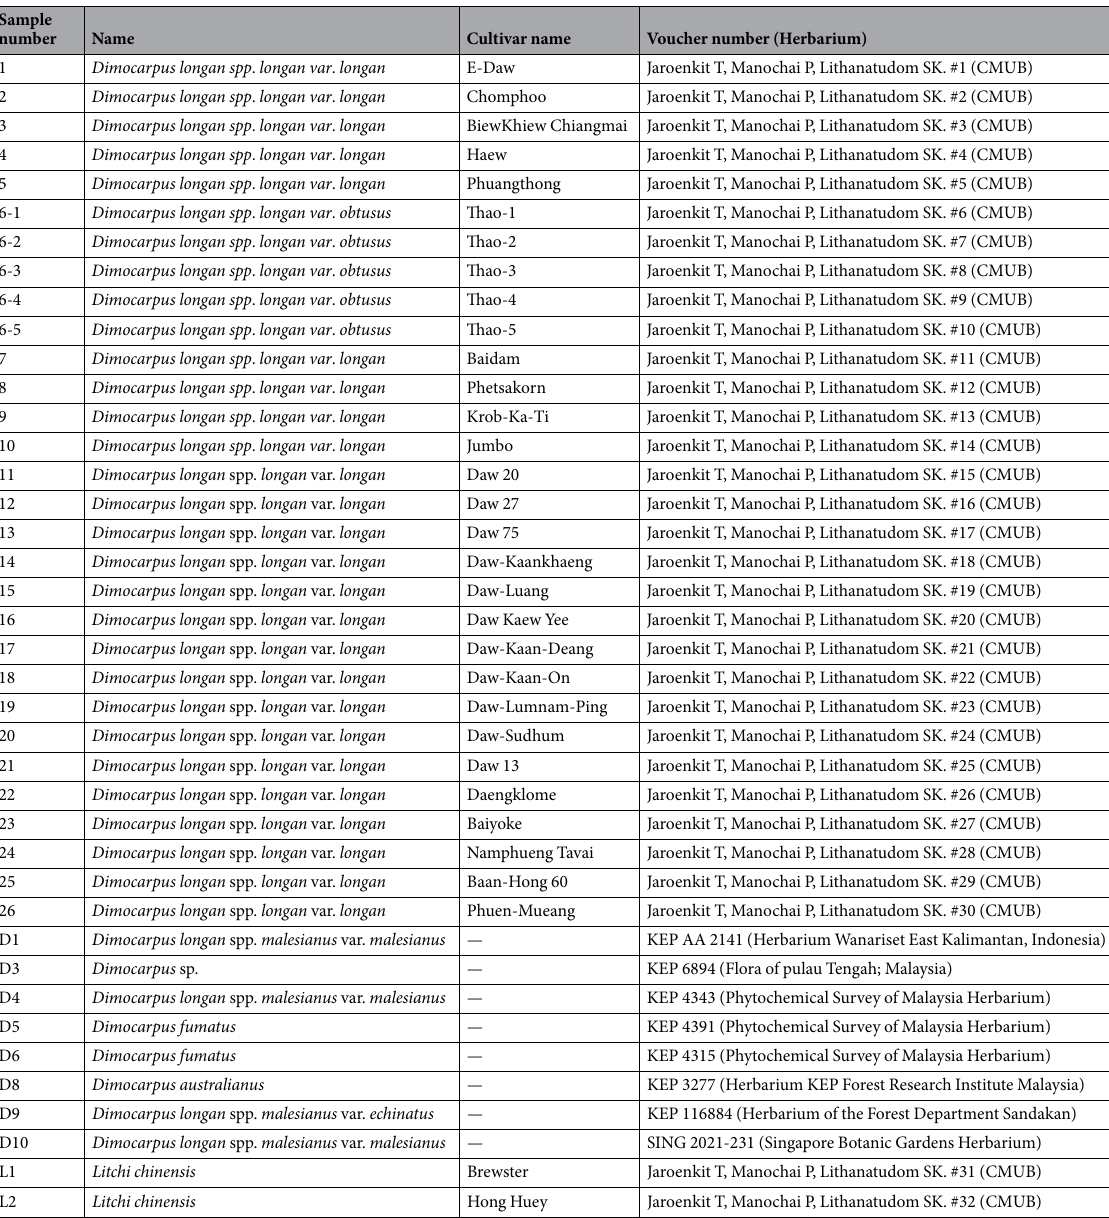
Table 2. Sample code, cultivar name voucher number and herbarium of plant